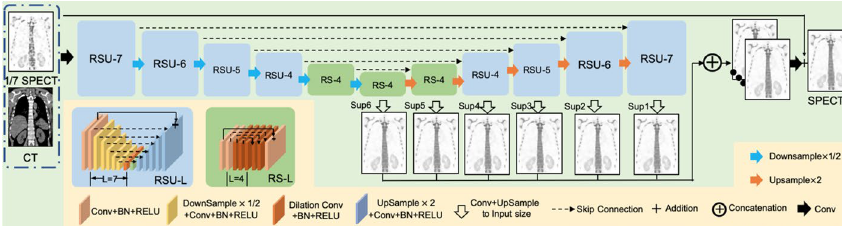
Fig. 2 Illusion of proposed U 2 ‑Net architecture. It consists of 4 residual U‑block (RSU) encoders with height of L, 3 bottom residual block (RS) and 4 symmetric RSU decoder. Skip connections are used to save spatial information along matched encoders and decoders. 1/7 SPECT and corresponding CT image are used as the input. The output of the network is images convoluted and upsampled from the second and third RS and follow‑up